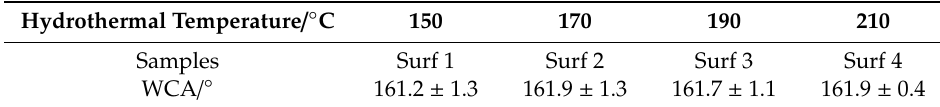
Table 1. Water contact angle of all micro / nano-hierarchical surfaces.